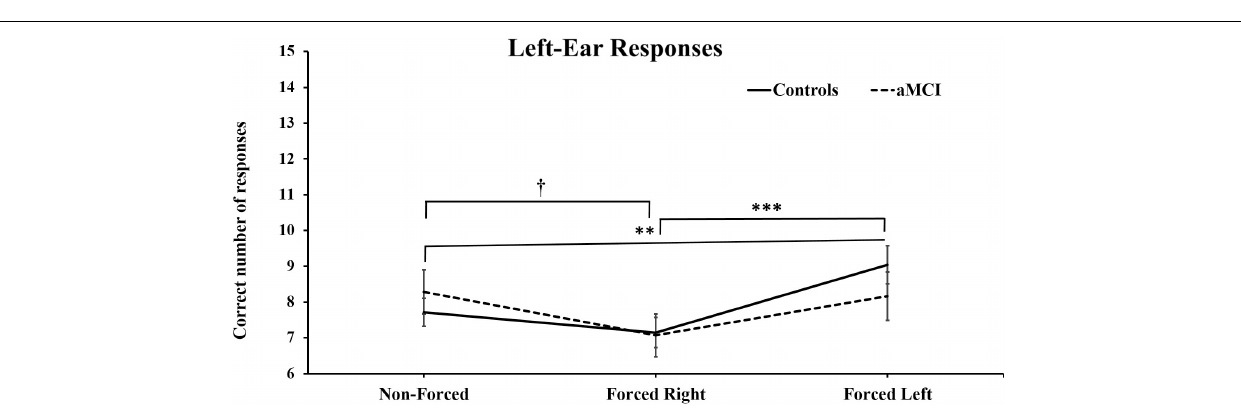
FIGURE 3 | Mean and ± SEM for correct left-ear responses across three dichotic listening conditions. aMCI, amnestic Mild Cognitive Impairment. The reported † denotes significant differences of p < 0.05 for aMCI group and the ∗∗ and ∗∗∗ denotes significant differences of p < 0.01 and p < 0.001 ) respectively, for healthy